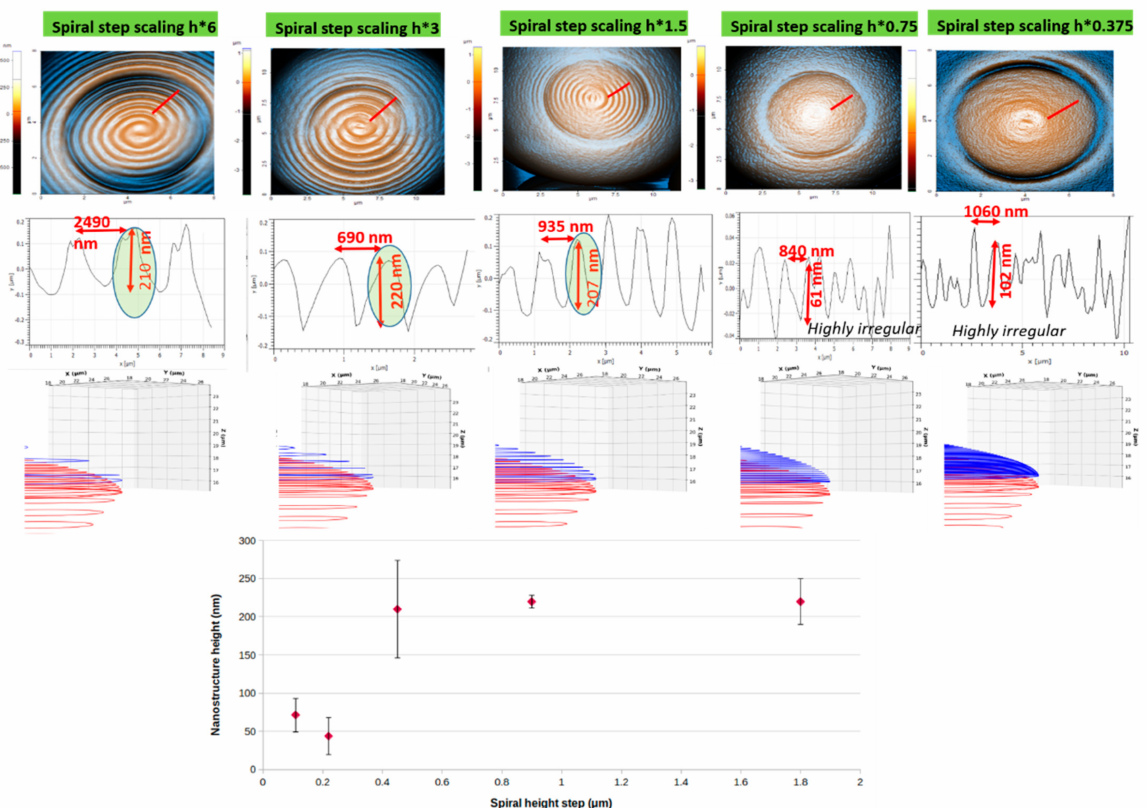
Figure 5. ( Upper panel ) Atomic force microscopy images (AFM) (enhanced colors) of dual-scale structures in the shape of nanostructured mushroom-like pillars (NMPs) fabricated by LDW via TPP of IP-Dip photopolymer using the same writing parameters and different designs/geometries; ( Middle panel ) 2D profiles along radial segments across the structures imaged in the upper panel; ( Middle panel ) Simulation of the laser path with different scaling of the spiral step in the z-direction (side view of the pillar lid). For all structures, the laser power was 13.25 mW and the scanning speed was 100 µ m/s. ( Lower panel ) Nanostructures’ heights as a function of spiral step (the error bars are the statistical